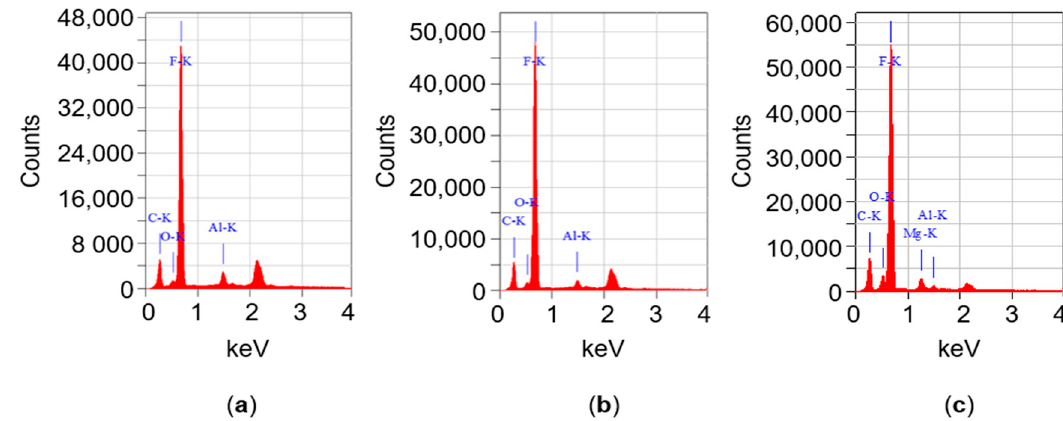
Figure 3. EDS spectra of PTFE/Al 2 O 3 -4 ( a ), PTFE/BA80-4 ( b ) and PTFE/MG70-4 ( c ) samples. The unmarked peak (~2.1–2.2 keV) is related to the sputtered gold (Au) on the sample surfaces.